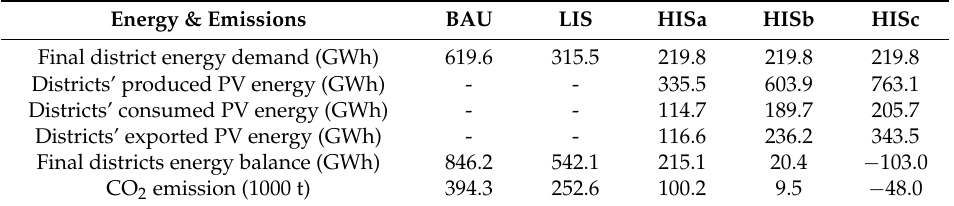
Table 4. Annual final energy demand of the heating and cooling systems for the residential sector in New Borg El Arab City, PV produced, consumed and exported energies and final energy balance, which includes the appliances’ energy consumption of each scenario [28].